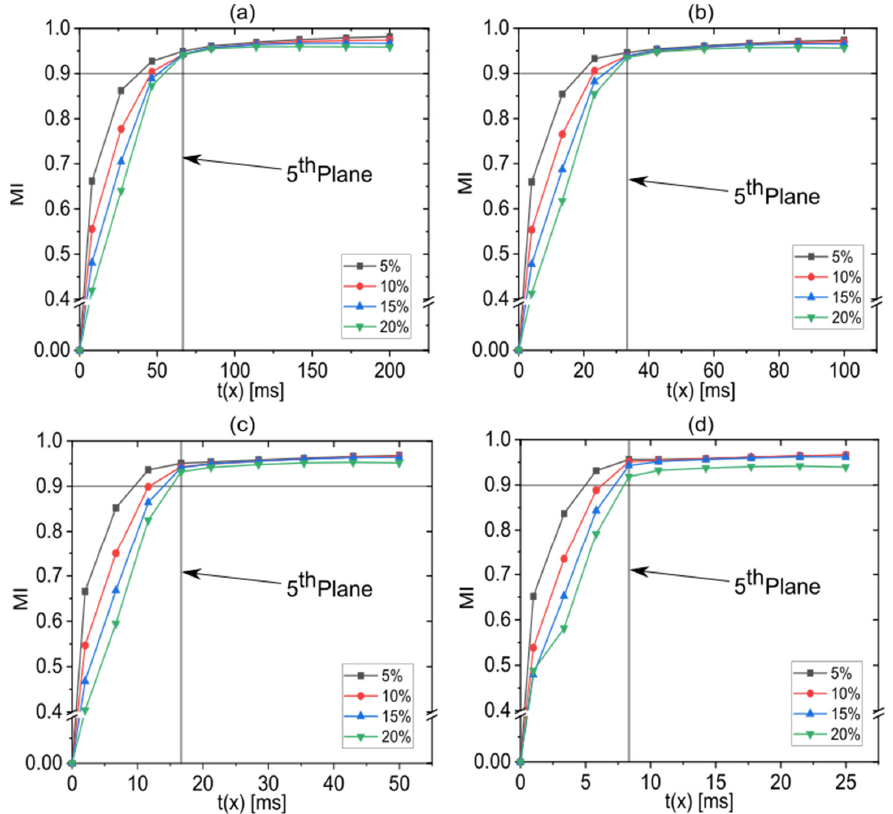
Figure 6. MI as function of elapsed residence time for flow rate ratios varied between 5% and 20% at constant total flow rates of ( a ) 50 μ L/min, ( b ) 100 μ L/min, ( c ) 200 μ L/min and ( d ) 400 μ L/min. Straight vertical lines indicate the position of the fifth plane at which the third stretch-and-fold unit is passed and after which the curves practically overlap. For data above the straight horizontal lines practically complete mixing (MI > 0.9) is achieved.